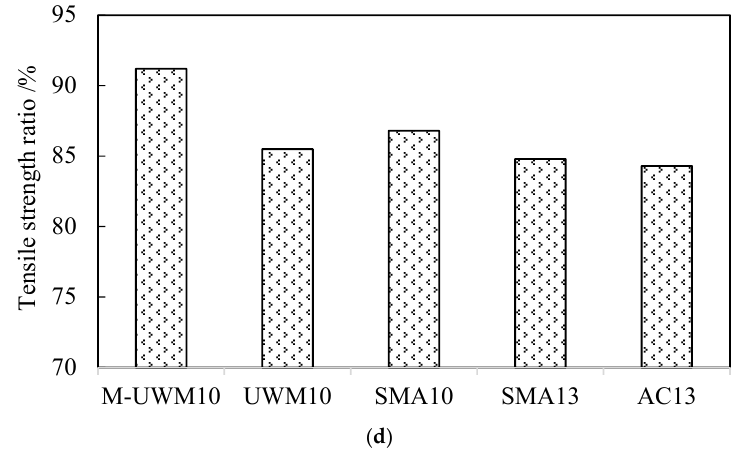
Figure 5. Test results for road performance evaluation: ( a ) dynamic stability; ( b ) failure strain; ( c ) Marshall stability ratio; ( d ) tensile strength ratio. Table 3. Pavement performance verification for the M ‐ UWM10 mixture